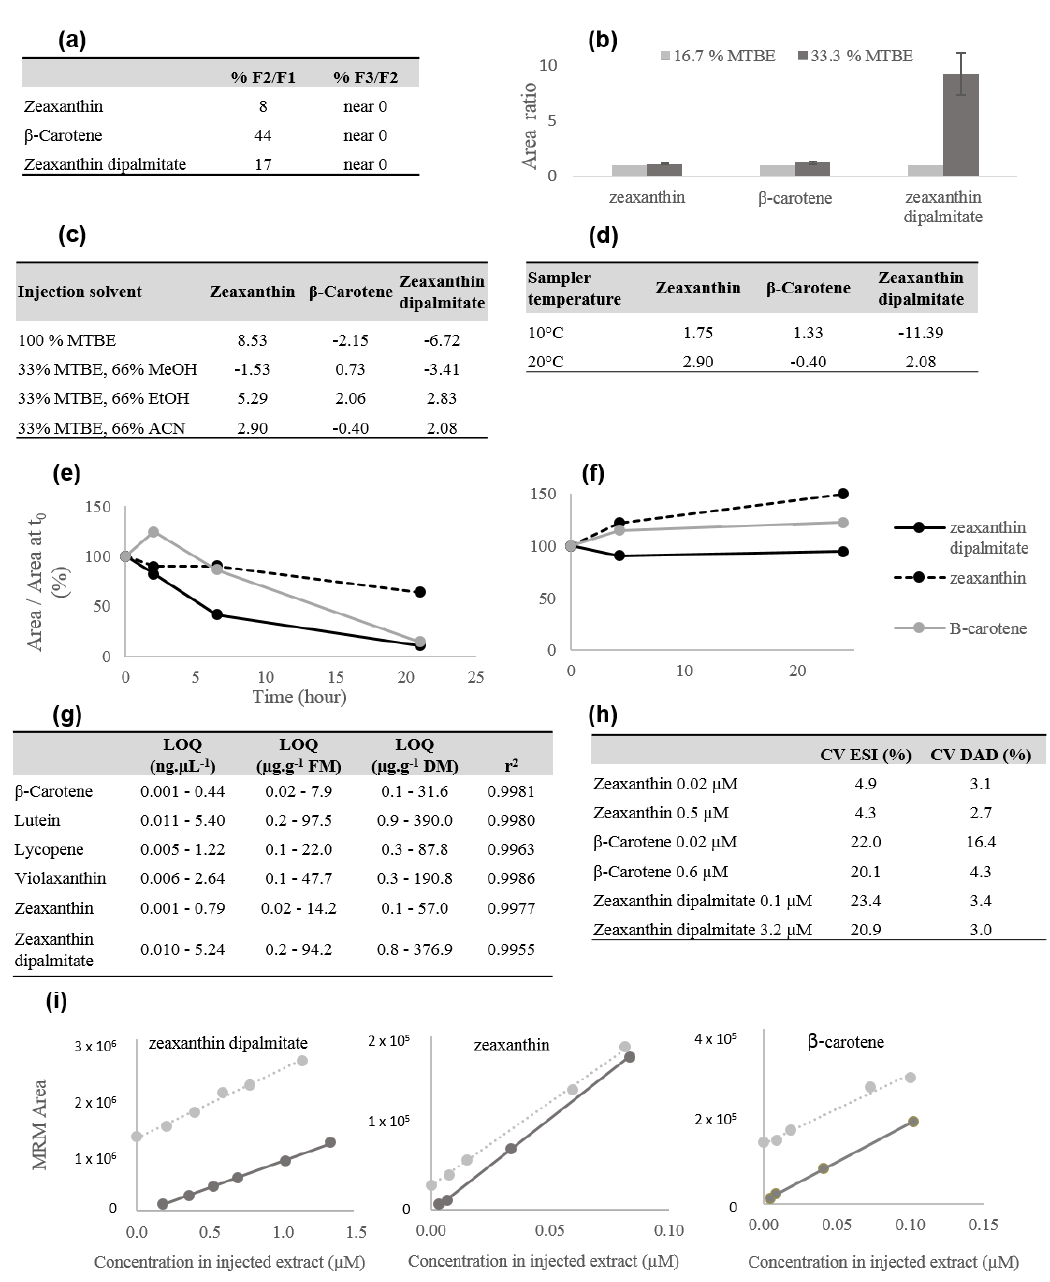
Figure 1. Carotenoid extraction optimization and quantitative analysis validation. ( a ) Determination of the minimum number of successive extractions to recover the carotenoids; 3 fractions (F1–F3) were obtained, and the Multiple Reaction Monitoring (MRM) peak areas ratios were reported. ( b ) Impact of the MTBE percentage in the injection solvent on the MRM signal intensities. ( c ) Impact of 4 di ff erent injection solvents on the variation rate of the MRM peak area over 4 h, expressed as the percentage of variation per hour. ( d ) Auto-sampler temperature e ff ect on the carotenoid stability, expressed as the percentage of MRM peak area variation per hour. ( e , f ) Carotenoid stability estimated from the variations of signal intensities over time before ( e ) and after ( f ) method optimization. ( g ) Limit of quantification (LOQ) expressed as ng. µ L –1 of extract and µ g.g –1 of fresh or dry weight; the response linearity r 2 was calculated from the standard mixture at a minimum of 3 concentration levels. ( h ) Precision of the method estimated from the ESI or DAD peak areas coe ffi cient of variation (%) from 9 injections over 2 days, given for 2 concentrations. ( i ) Evaluation of the matrix e ff ect on MRM peak areas, dose / response curves of pure standard (black) and standard added to goji extract